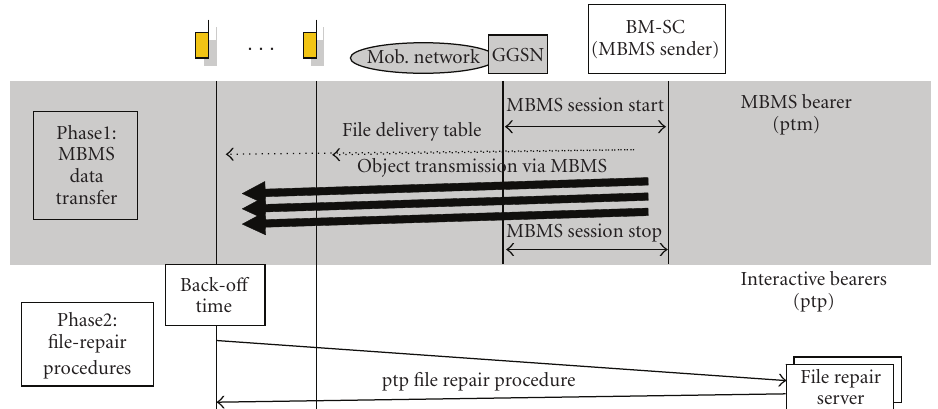
Figure 10: MBMS Download procedure principle with point-to-point file repair.